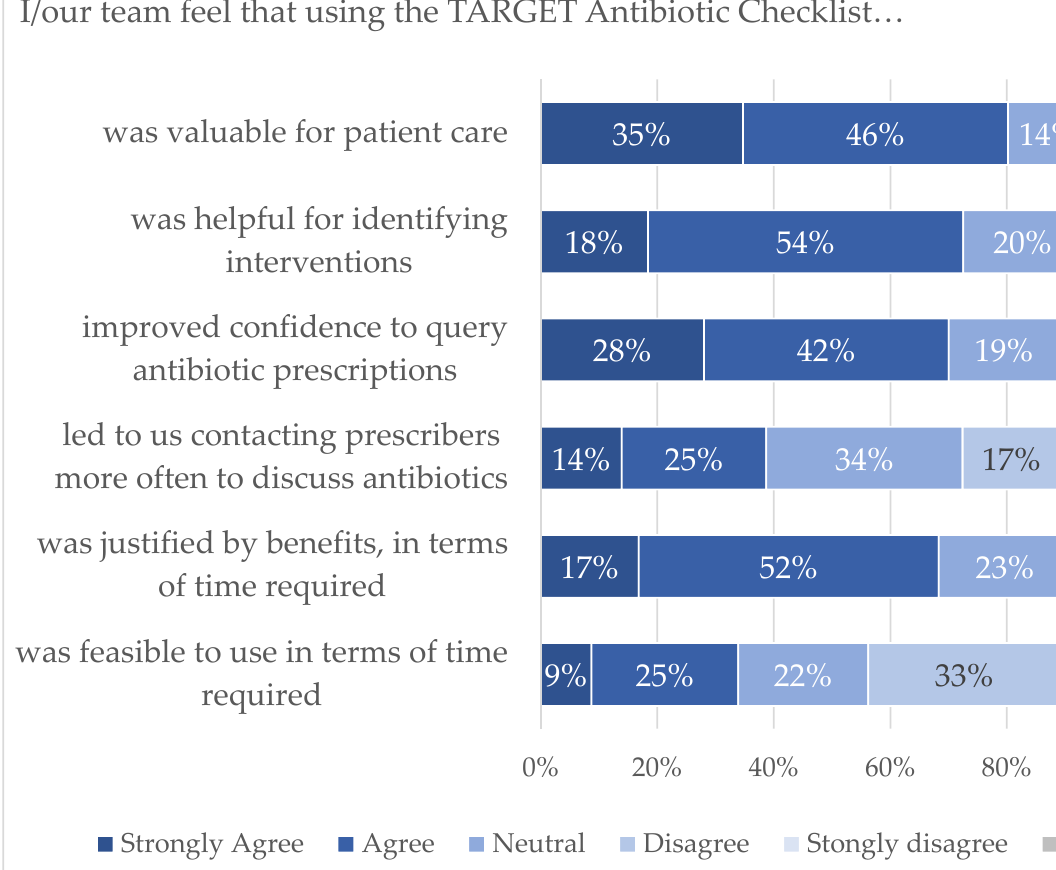
Figure 4. Pharmacy staff feedback on TARGET Antibiotic Checklist .